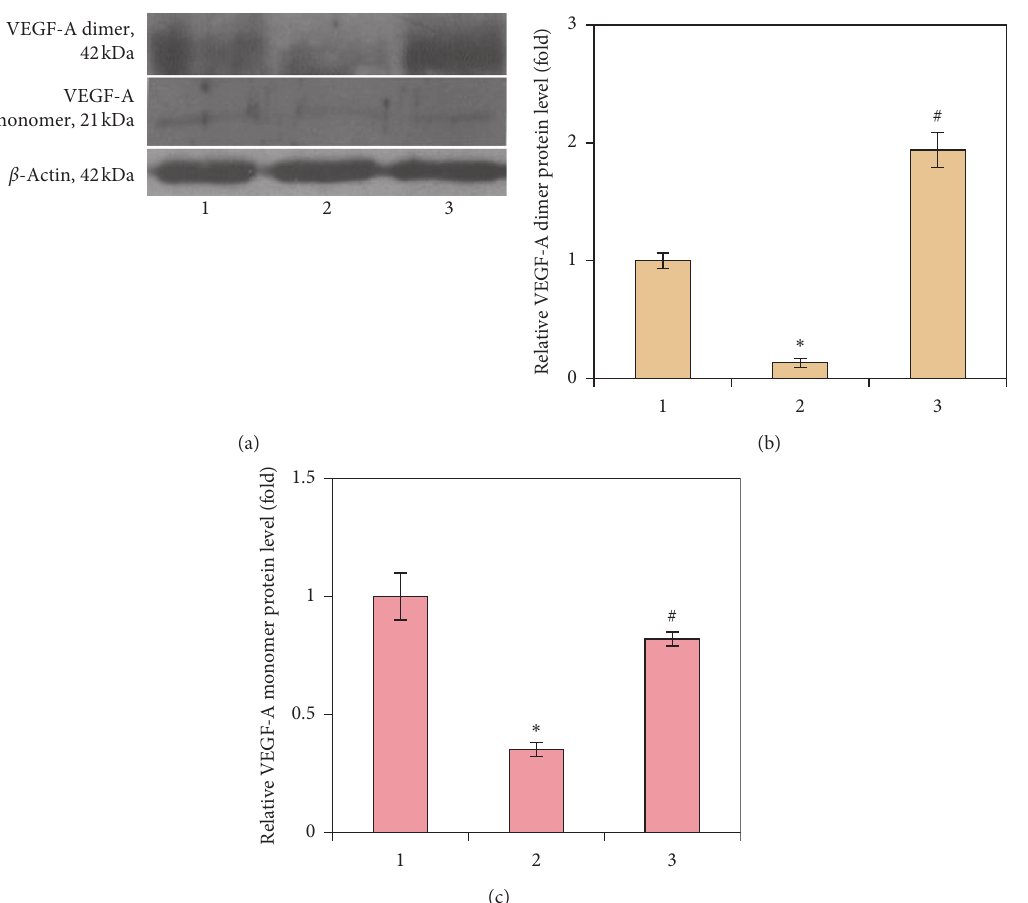
Figure 5: Effects of prednisolone and vitamin D 3 administration on the protein level of VEGF-A in bone tissue: (1) control; (2) prednisolone administration; (3) prednisolone and vitamin D 3 administration. Representative immunoblots (a) and quantification of VEGF-A dimer (b) and VEGF-A monomer (c) are shown. Protein levels were normalized to β -actin. Results are shown as mean ± SEM of three independent experiments done in triplicate; ∗ p < 0 . 05 vs. control; # p < 0 . 05 vs. prednisolone